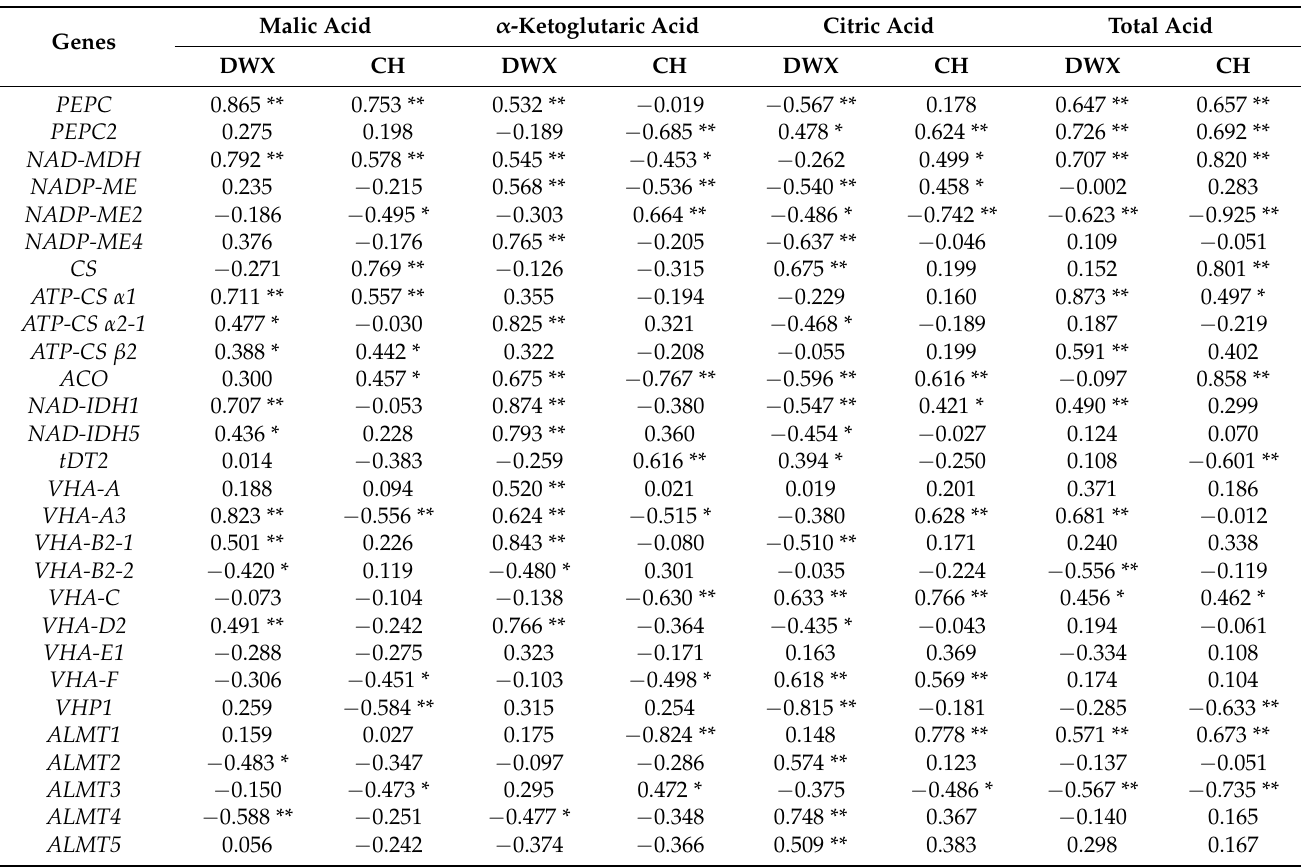
Table 4. Correlation analysis of organic acids with related genes